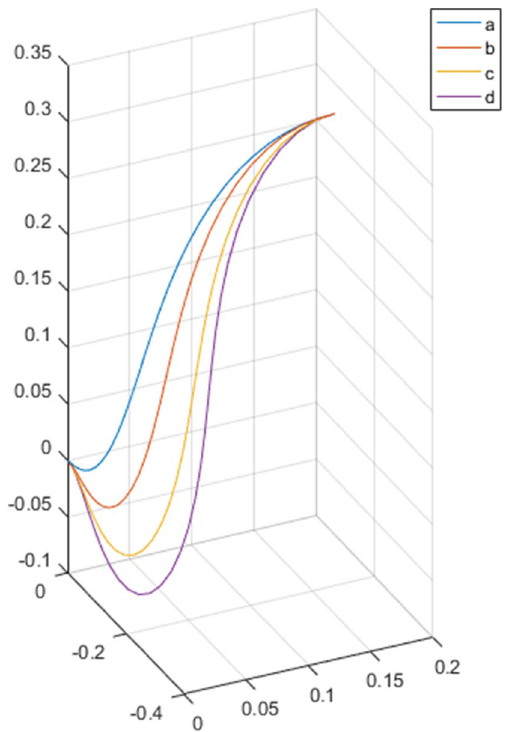
Figure 14. Cable simulated shape change with increasing length.